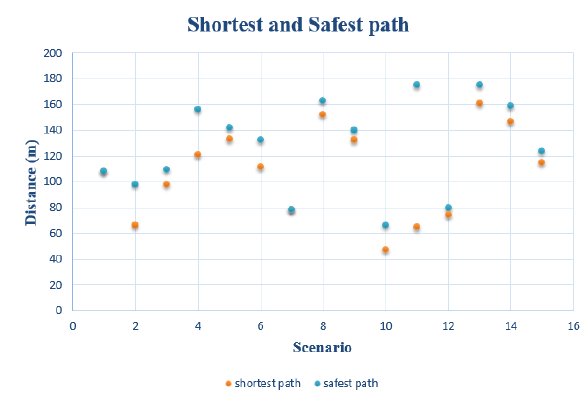
Figure 13. Scenarios of the safest and shortest